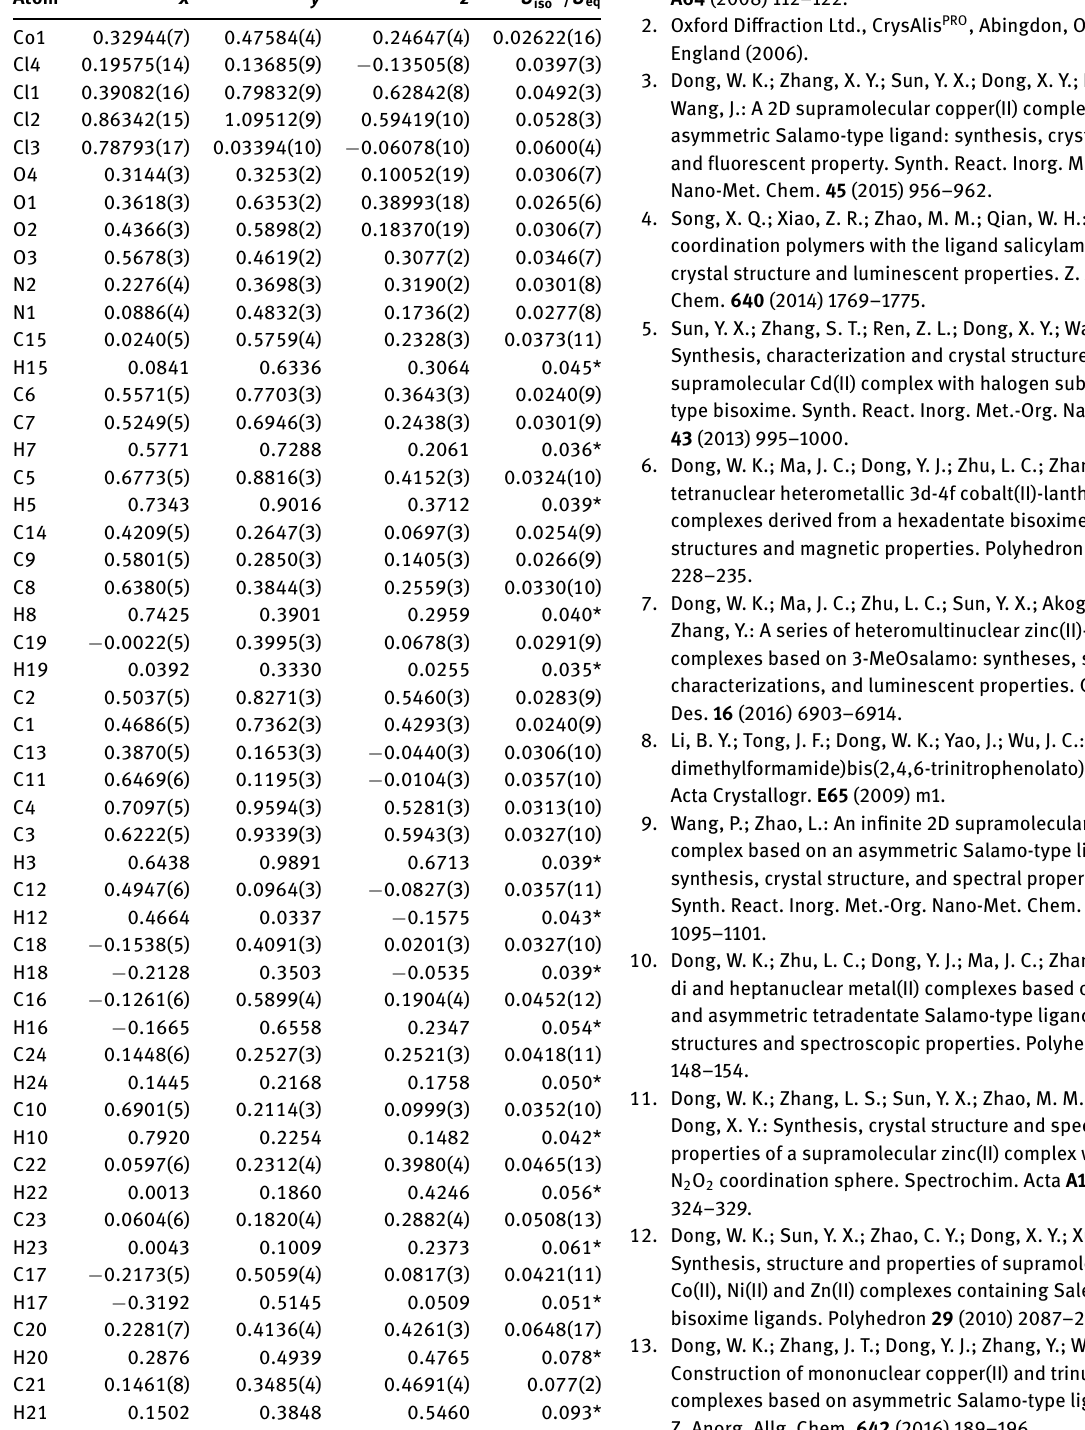
Table 2: Fractional atomic coordinates and isotropic or equivalent isotropic displacement parameters (Å 2